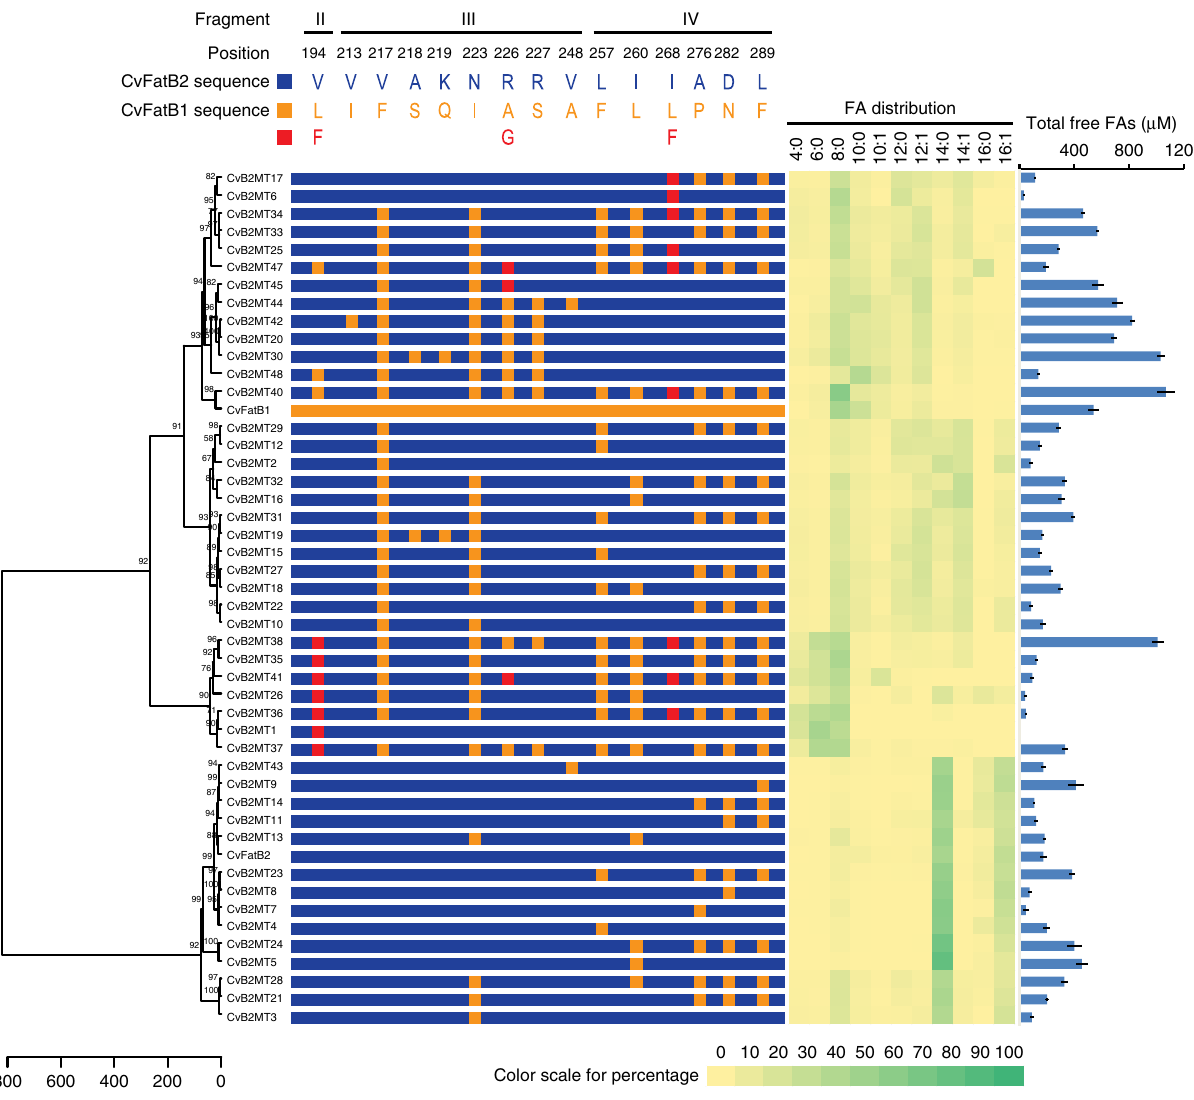
Fig. 2 Clustering CvFatB2 mutants based on the in vivo FA pro fi les produced in E. coli . The distance matrix was calculated using Euclidean distances, and Ward ’ s method was used to perform agglomerative hierarchical clustering. The approximately unbiased (AU) p -values were calculated via multiscale bootstrap resampling with 1000 replicates. The central panel schematically identi fi es the positions of residues that were mutated in the CvFatB2 sequence (blue colored). The 15 residues that were targeted for mutagenesis are identi fi ed and color-coded as either replacement with CvFatB1 residues (orange) or introduction of a residue not found in either CvFatB1 or CvFatB2 (red). The color-coded fatty acid pro fi le is shown on the right side. Major fatty acids produced by each mutant enzyme are highlighted with increasing green coloring (see scale). The graph on the right identi fi es the total free FAs accumulated in the medium. The data are the average of four replicates, and the error bar represents standard error of the